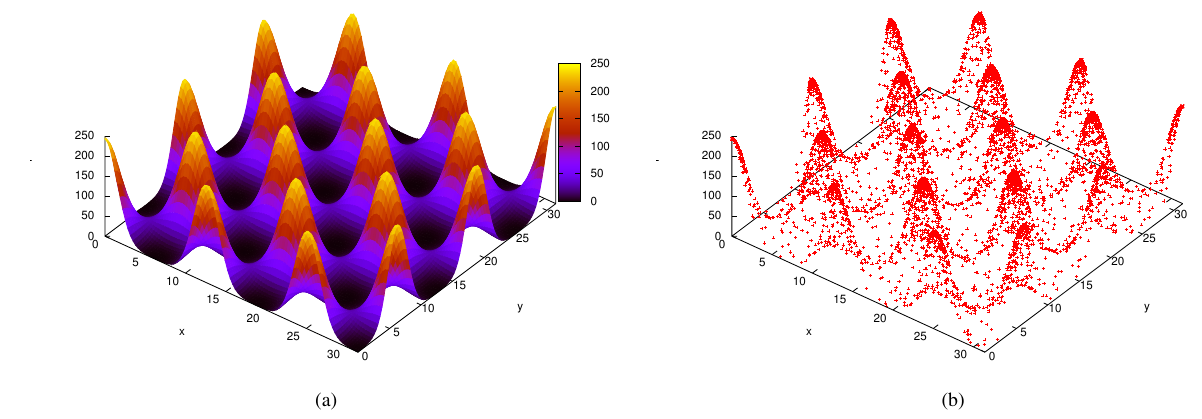
F IG . 4.— Test problem 2: (a) two-dimensional plot of the likelihood function defined in Eq. 23; (b) dots denoting the points with the lowest likelihood at successive iterations of the M ULTI N EST